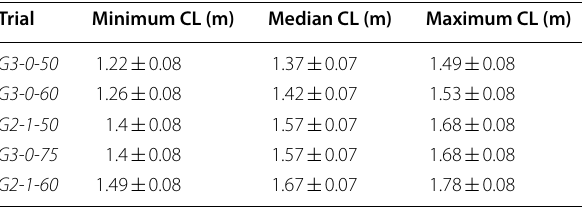
The two closely-related gaits, the G2-1 walk and the G3-0 ‘walking trot’, have similar predictions for coupling length CL for a range of duty factors. The minimum and maximum values refer to the extremes of CL for each trial, straddling the median